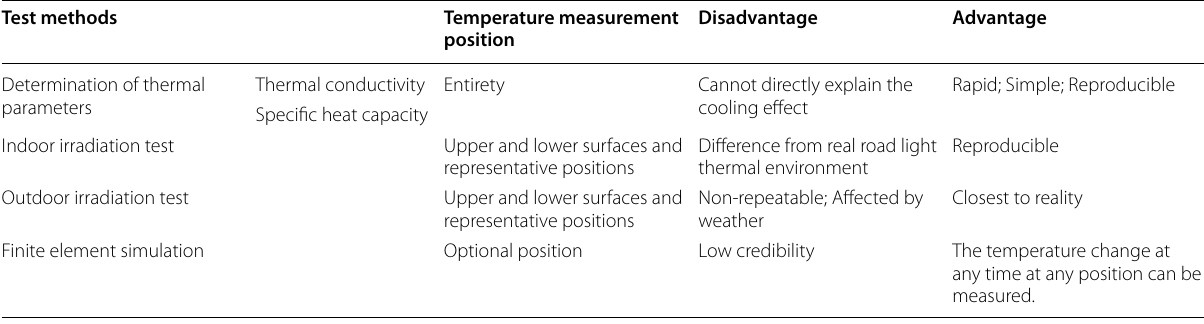
Table 3 Test method of cooling effect [66,